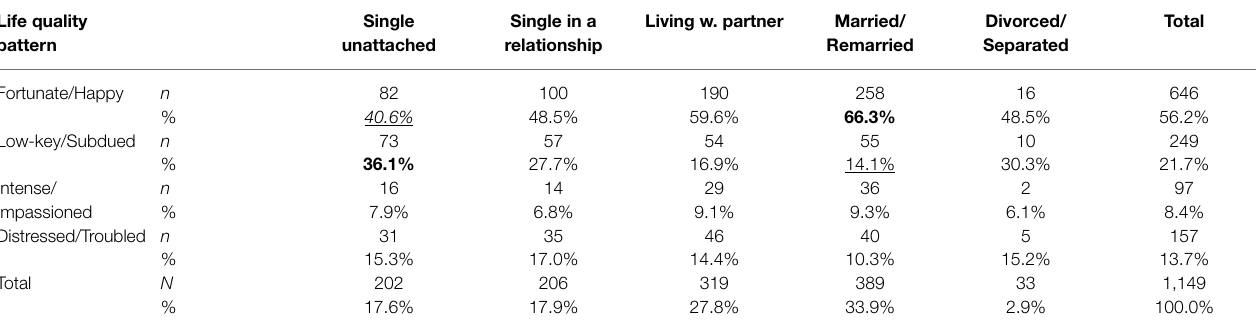
TABLE 5 | Trainees’ current life quality by marital/relationship status. 1,2